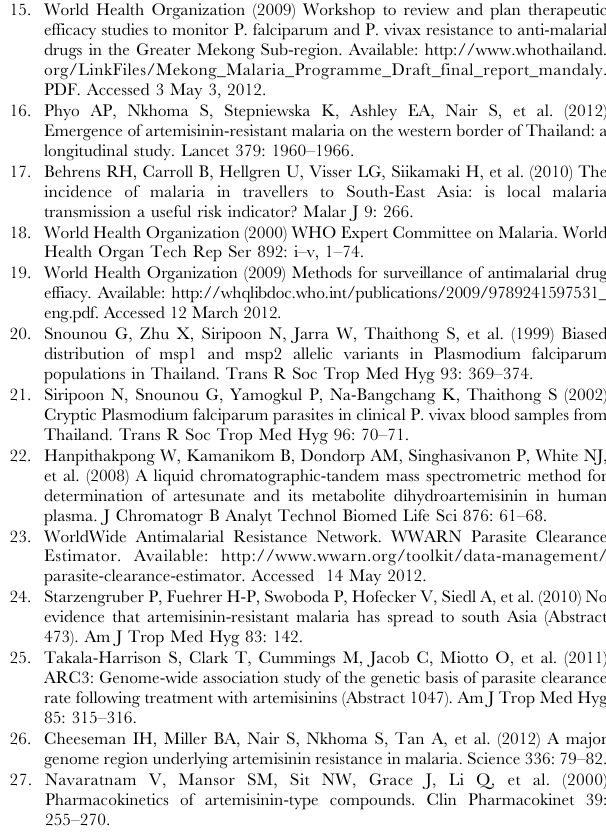
Figure S1 Map of Myanmar. The red star indicates the location of study site, Kawthaung. Figure S2 Lack of association between parasite clear- ance rate and initial parasite density. Figure S3 Lack of association between parasite clear- ance rate and maximal concentration of dihydroartemi- sinin. Figure S4 Lack of association between parasite clear- ance rate and total exposure of dihydroartemisinin.